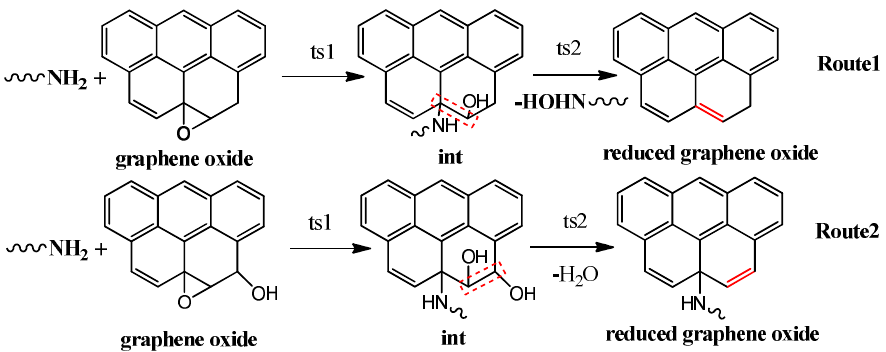
Scheme 1. Deoxygenation mechanism of GO reduced by